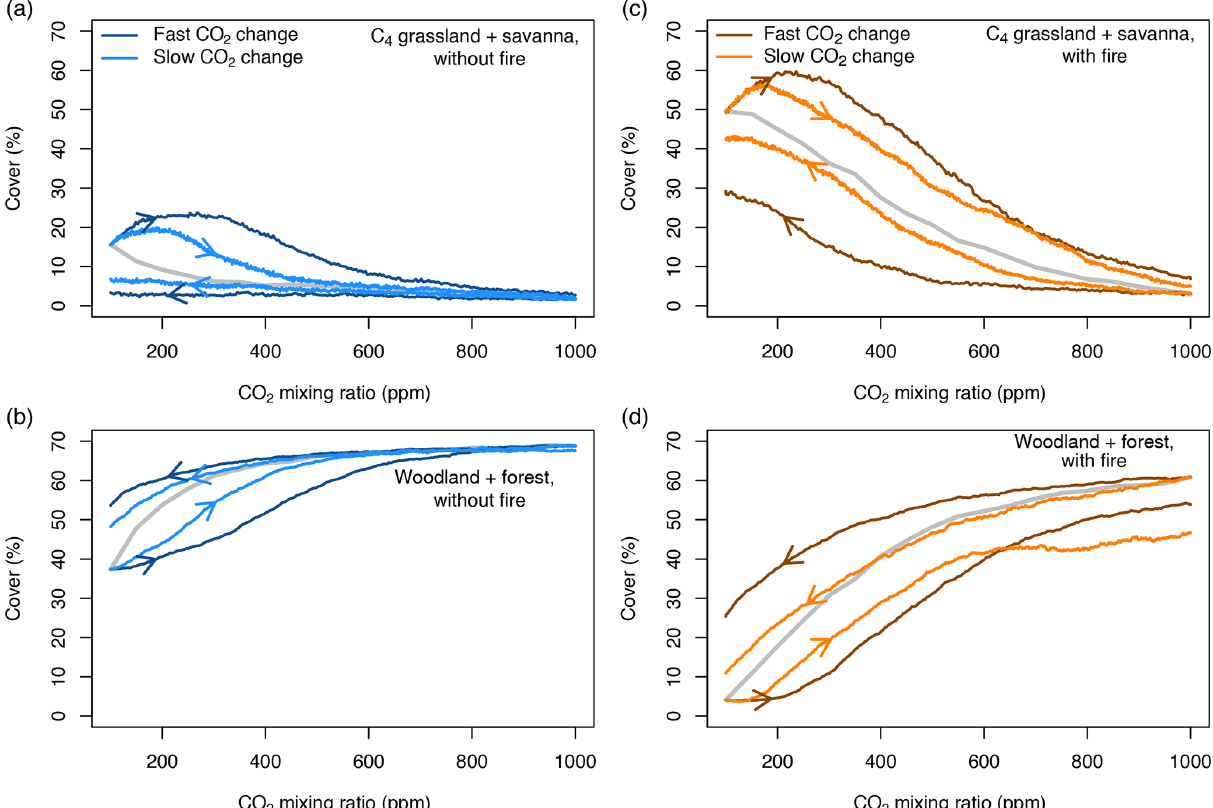
Figure 4. Percentages covered by C 3 - and C 4 -dominated vegetation in the presence and absence of fire. CO 2 is increased or decreased at two different rates between 100 and 1000ppm. The gray lines indicate vegetation cover in equilibrium simulations (similar to Fig. 1). Arrows indicate whether CO 2 increases or